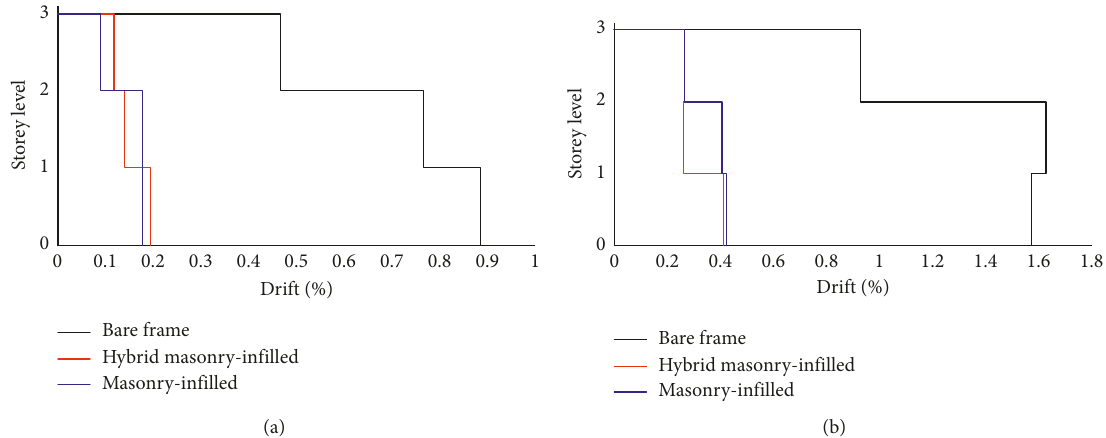
Figure 10: Maximum interstory drift envelope of test models for increasing input excitation. (a) Interstory drift demand under NR1. (b) Interstory drift demand under NR2.